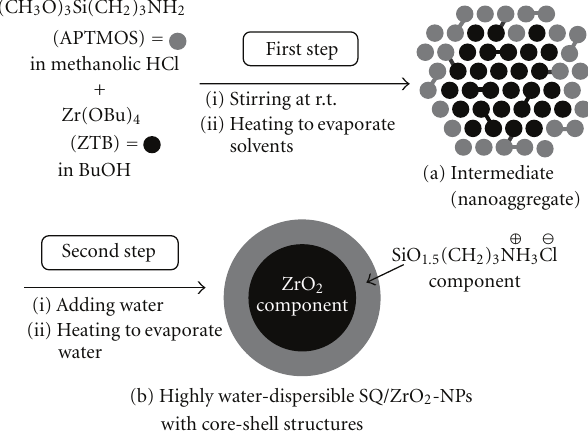
Scheme 2: Plausible formation mechanism of SQ/ZrO 2 -NPs with core-shell